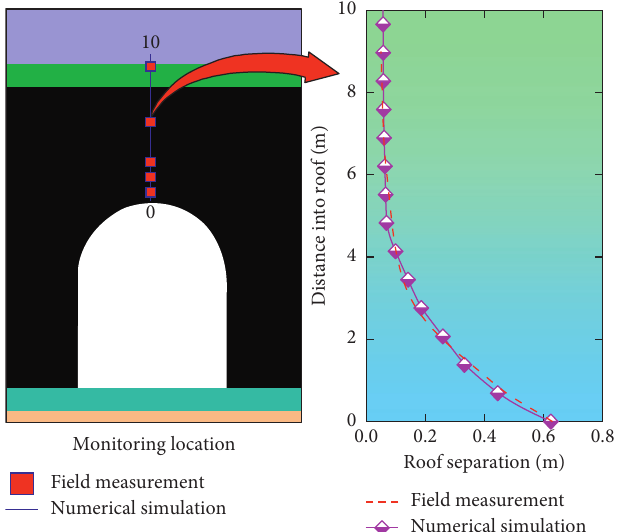
Figure 9: Comparison of the roof separation of numerical simulation and field